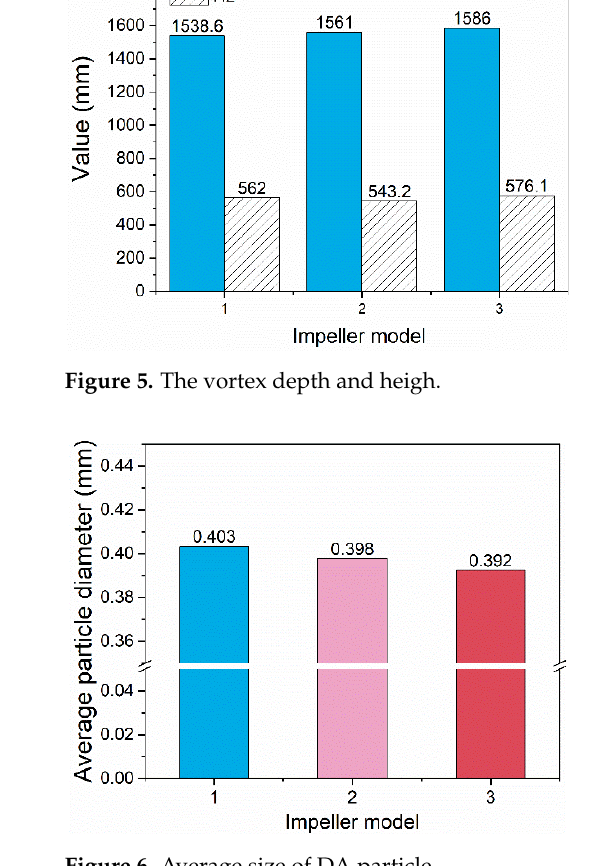
Figure 6. Average size of DA particle.